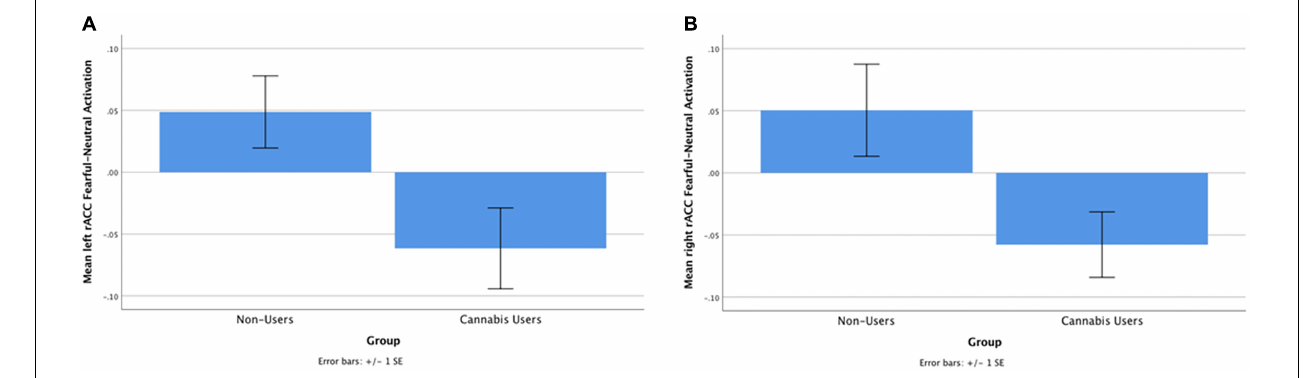
FIGURE 1 | (A) Cannabis users, compared with controls, demonstrated significantly less left rACC activation during fearful-calm No-go trials [ t (48) = –3.08, beta = –0.42, p = 0.003]. (B) Cannabis users, compared with controls, demonstrated significantly less right rACC activation during fearful-calm No-go trials [ t (48) = –3.07, beta = –0.42, p = 0.003]. TABLE 2 | Regions with significant differences in functional connectivity with the rACC for various contrasts. MNI coordinates x, y, Brain region (s) Peak Voxel-level Number of Direction of z (mm) T -score significance voxels connectivity